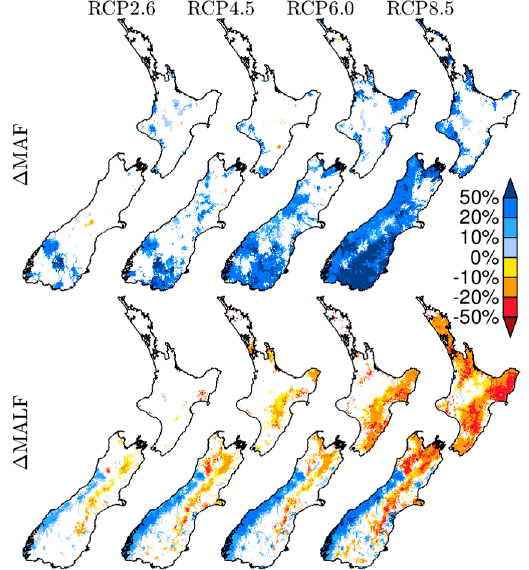
Figure 5. Late ‐ century percentage changes in MAF and MALF across four RCPs relative to Figure 5. Late-century percentage changes in MAF and MALF across four RCPs relative to the reference the reference period. White indicates statistically insignificant differences. period. White indicates statistically insignificant di ff